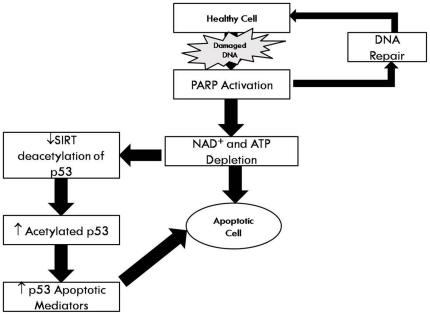
Schematic representation for the association between oxidative stress,
PARP-mediated and decline in NAD+ content, and
NAD+ dependent functions with aging.Oxidative stress to DNA activates PARP leading to poly(ADP-ribosylation) of
proteins in a reaction which consumes NAD+. Depletion of
cellular NAD+ stores attenuates the activity of Sirt1
deacetylase leading to hyperacetylation of p53, and consequently tilting the
balance to cell death via an apoptotic mechanism.